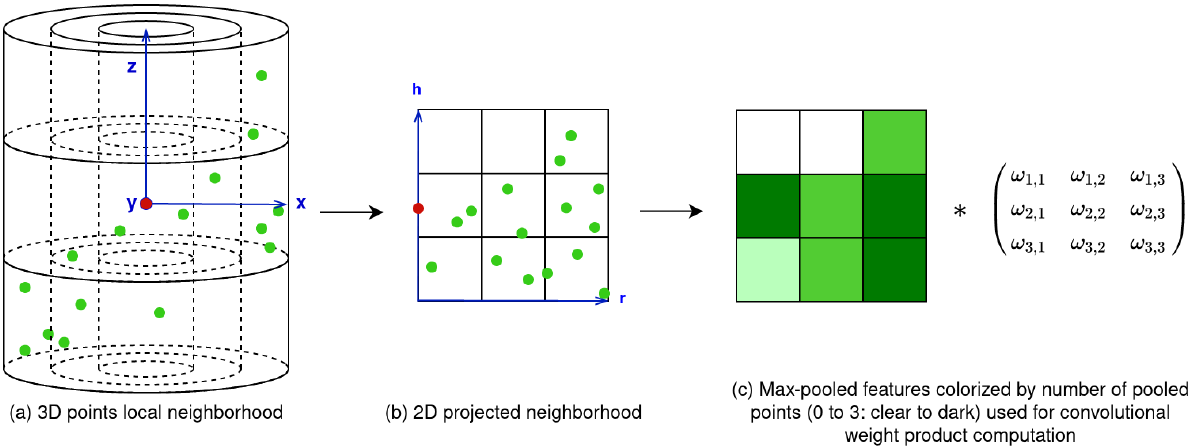
Figure 4. Successive steps for performing local projective cylindrical convolution with: (a) the 3D cylindrical neighborhood (green) centered around the query point (red); (b) the spatial 2D projection and partitioning of the neighborhood; (c) the max-pooling of the neighborhood points’ attached spectral features into a 3 × 3 grid used as a convolution support for the weight matrix Ω 3 ×